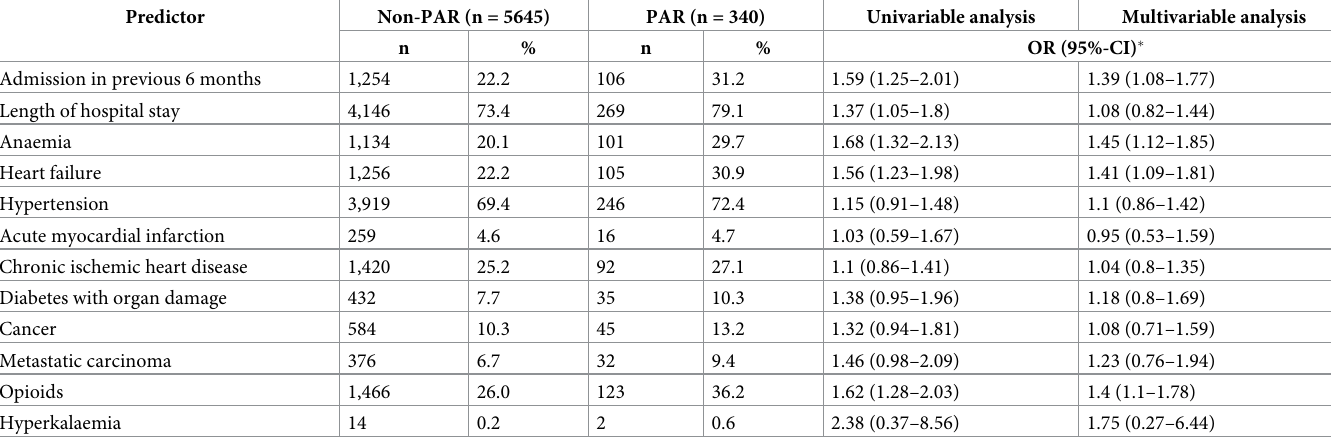
Table 2. Unadjusted and adjusted associations between predictor and potentially avoidable readmission (PAR).